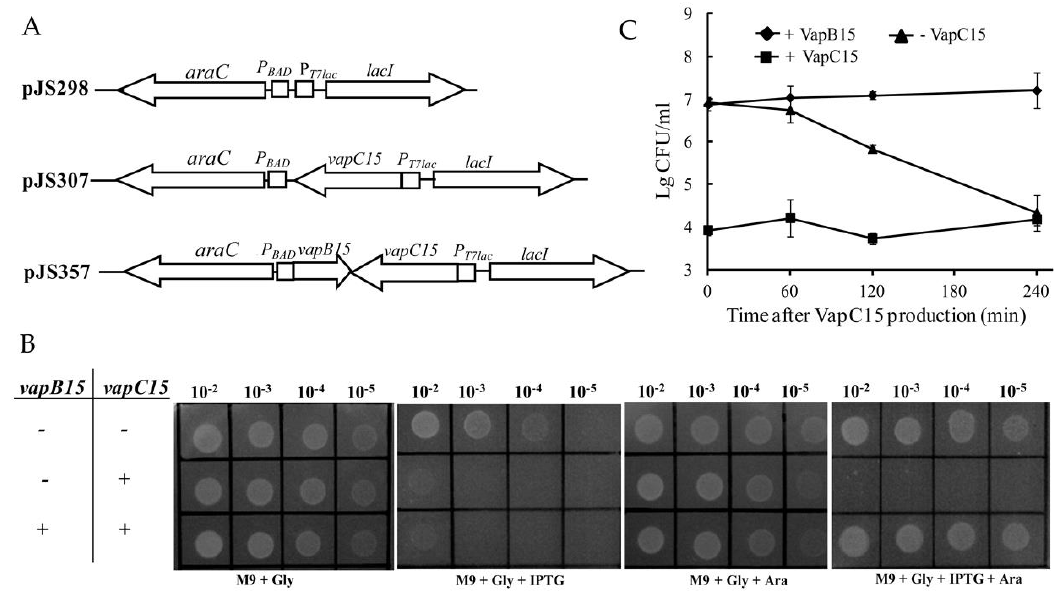
Figure 1. Effects of VapB15 and VapC15 on E. coli growth. ( A ) Schematic diagram illustrating the structure of the selection expression plasmids. ( B ) Drop dilution assays for the effects of ectopic production of VapBC15 components on E. coli growth. + or − indicates the presence or absence of the vapBC15 genes in E. coli BL21(DE3) cells, ( C ) Growth-rescue analyses for toxic effect of VapC15 using E. coli BL21(DE3) cells containing pJS357. + indicates the induction of VapB15 or VapC15 expression. − indicates the stop of VapC15 expression. Data points represent the means of three independent cultures and the error bars represent standard deviation (SD).